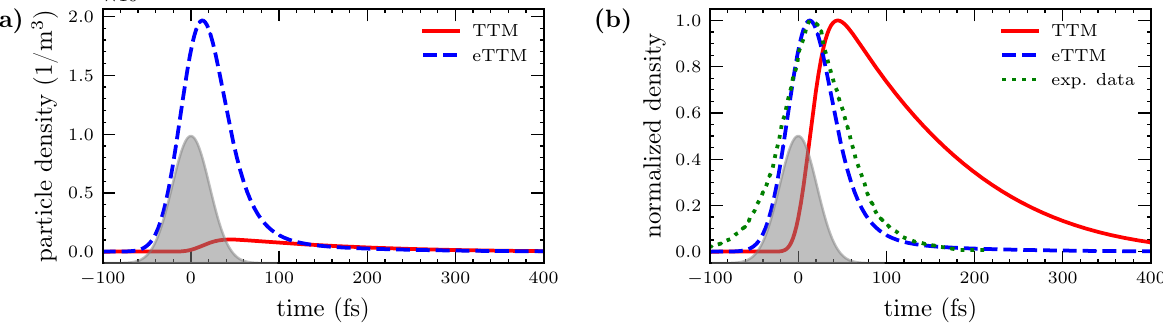
Figure 6. Dynamics of the particle density integrated over the energy range 1 eV to 1.5 eV above the Fermi edge. In Figure ( a ), the result of a TTM simulation is compared to an eTTM simulation. In the eTTM, a significant number of high-energetic electrons are generated directly with the laser pulse and thermalize about 50fs after the laser. In contrast, the particle density in the TTM only rises with a delay and to a much weaker amplitude. Both spectral densities are normalized in Figure ( b ). Additionally, experimental data from [24] are shown. A good agreement of the curve obtained with the eTTM simulation can be observed, even though the experiment was performed on another material (gold instead of aluminum). In contrast, the spectral density obtained with the TTM shows a much slower